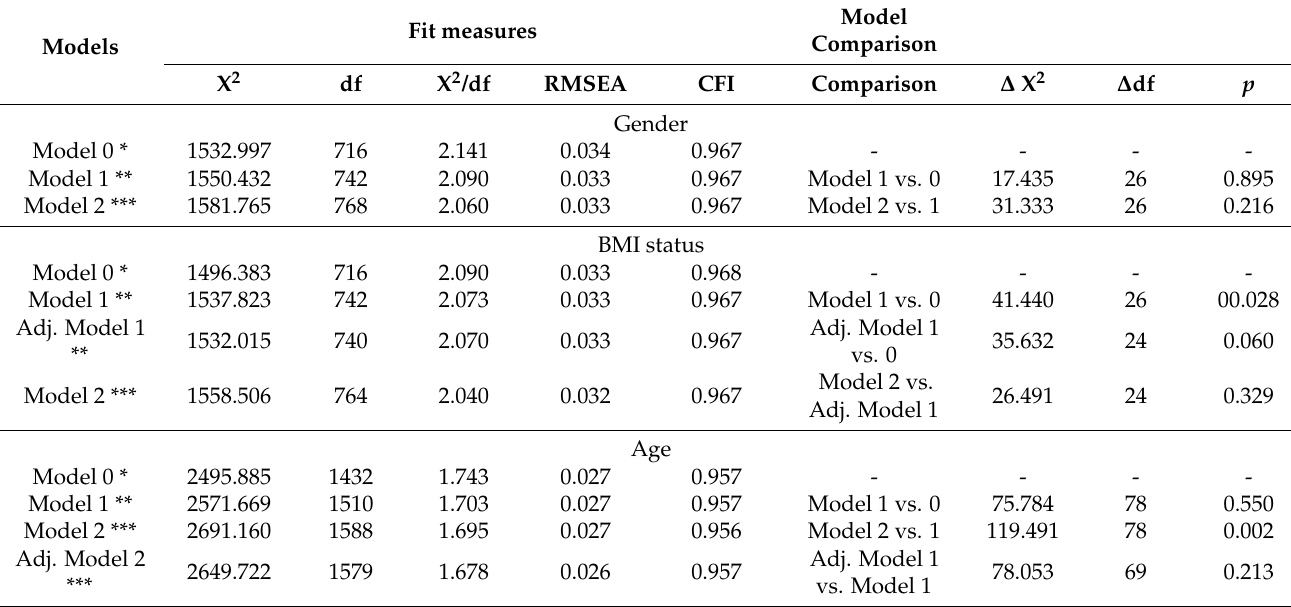
Table 5. Fit measures for the DEBQ multi-group